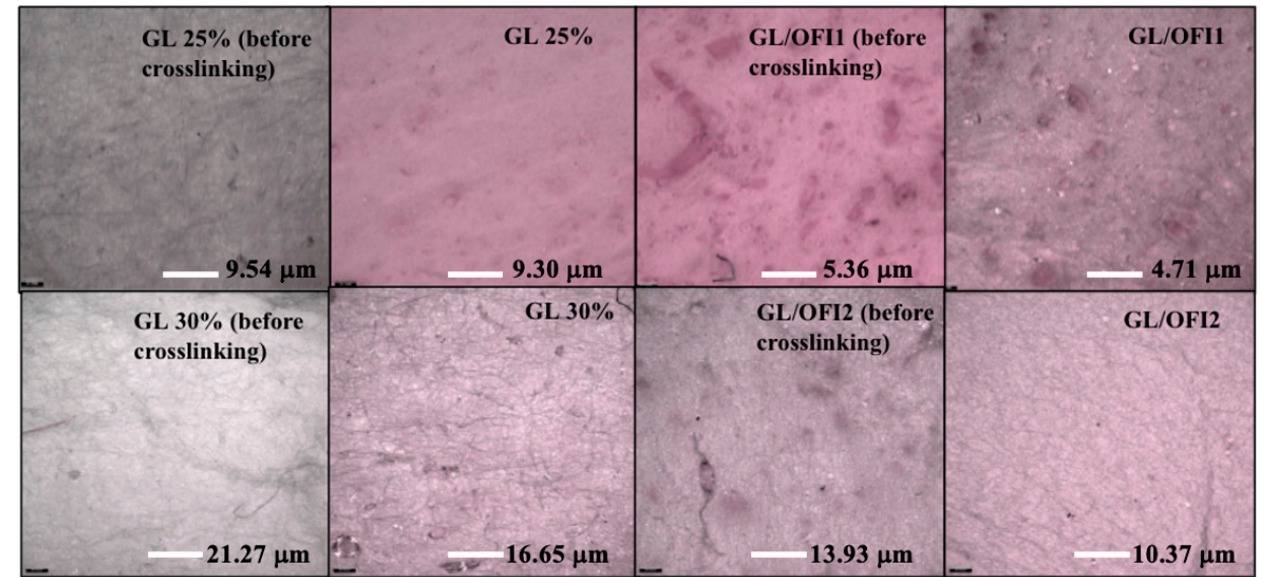
Figure 5. Roughness comparison of fibers with different concentrations of gelatin (GL) without or with OFI extract (GL/OFI) before and after crosslinking.